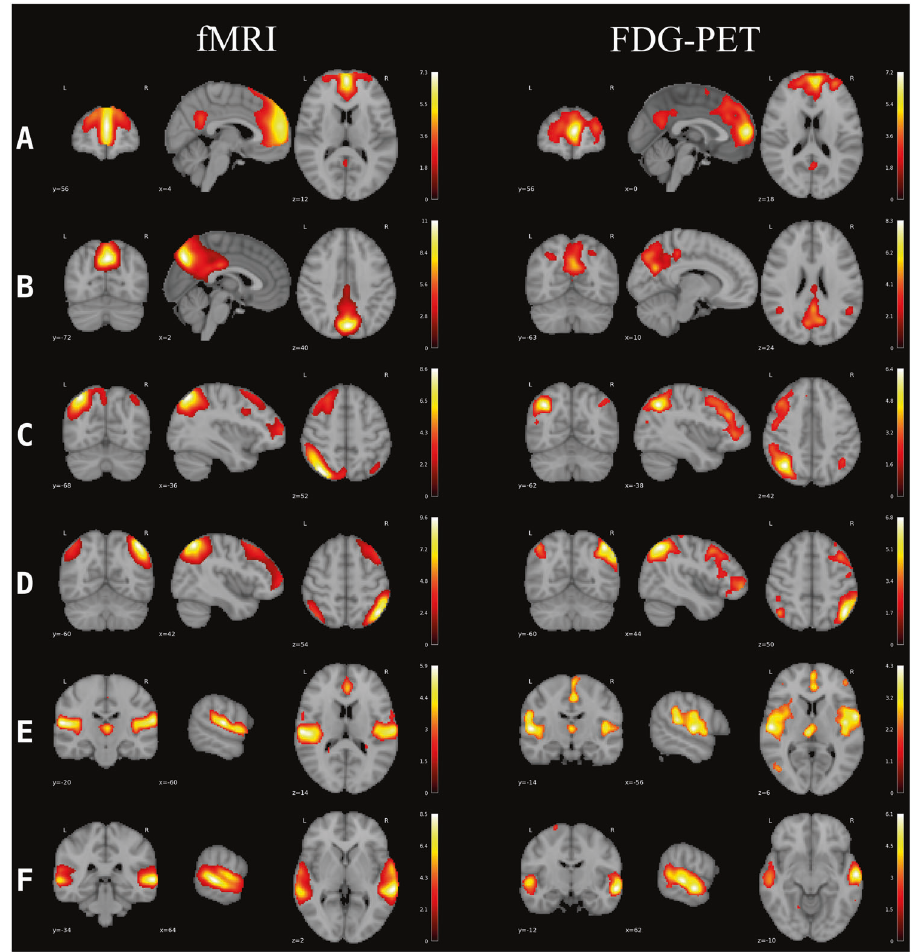
Fig. 4 Resting state networks of interest in the PET data. Overlay of independent component maps onto the T1 template in the Montreal Neurologic Institute space at a threshold of z > 2.0. Colour bar represents z -values. A anterior default mode network, B posterior default mode network, C left central executive network, D right central executive network, E salience network, F auditory